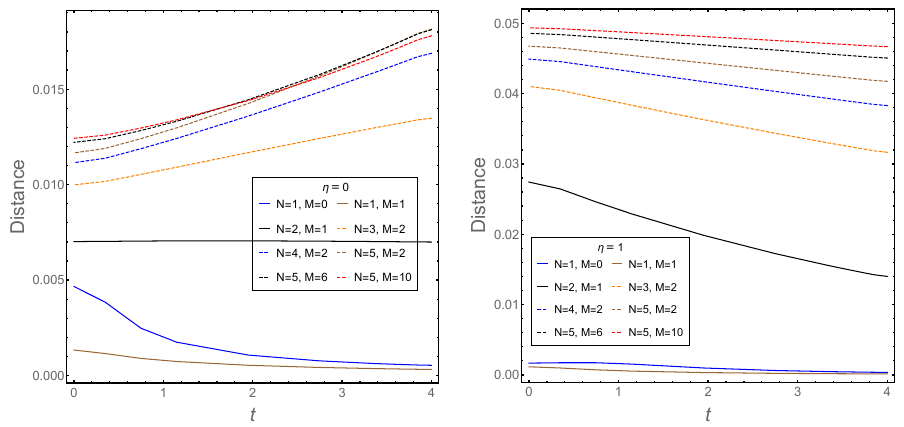
Figure 1 . Distances between the bound plane and a (cid:12)ducial point of b i of in the ( b 1 ; b 2 ; b 3 ; b 4 ; b 5 ; b 6 ) space for the cases of (cid:17) = 0 ; 1. The bound plane is depicted by Y (2 N;M ) ( t ) = a 0 + P 6